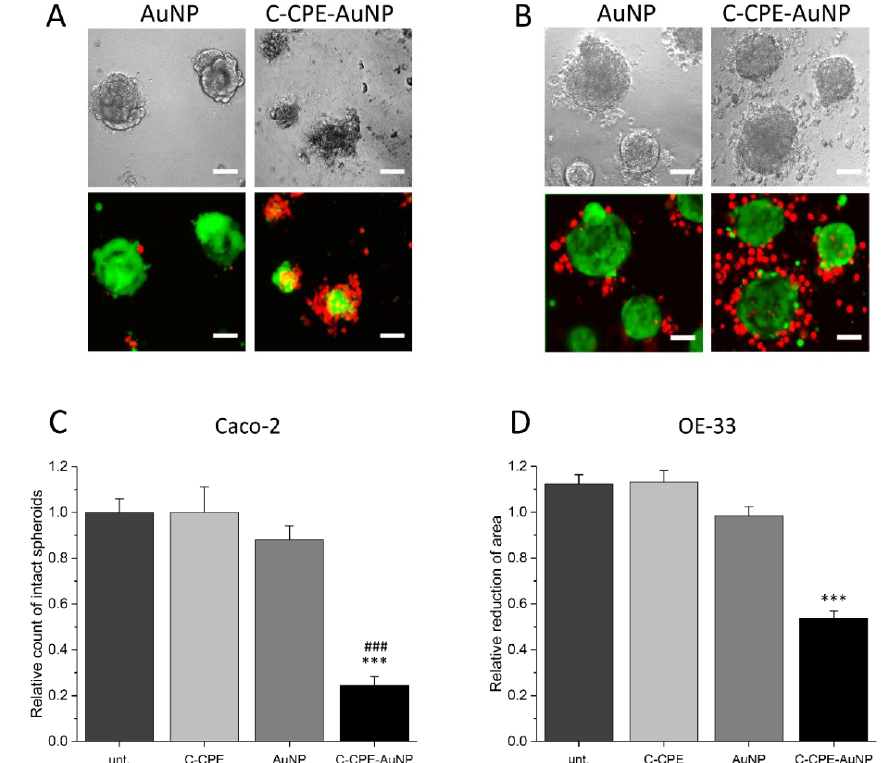
Figure 2. Caco-2 and OE-33 spheroids after three-time application of GNOME-LP. ( A , B ) Confocal images of Caco-2 (A) and OE-33 (B) spheroids treated with GNOME-LP in the presence of AuNPs or C-CPE-AuNPs. C-CPE-AuNPs destroyed Caco-2 spheroid structure and reduced cell survival as shown by the large amount of propidium iodide (red)-positive cells and the reduced amount of calcein-positive cells. For OE-33 spheroids, treatment with GNOME-LP in the presence of C-CPE-AuNPs induced cell death (propidium iodide-positive cells) in the peripheral regions. The cells in the core were still calcein-positive and propidium iodide-negative, indicating that they were still alive. Scale bar, 50 µm. ( C ) Quantification of intact Caco-2 spheroids indicating reduced intact spheroids after GNOME-LP with C-CPE-AuNPs. Graphs represent the mean ± SEM of intact spheroids count relative to spheroids before GNOME-LP application. The results were analyzed with Student’s t test. * Significant difference to untreated spheroids: *** p < 0.001 and ### p < 0.001 significant difference to the AuNPs treated spheroids. ( D ) Quantitative evaluation of OE-33 spheroid area showing that GNOME-LP applied in the presence of C-CPE-AuNPs reduced the spheroid area compared to the spheroid treated in absence of C-CPE-AuNPs. Graphs represent the mean ± SEM of the spheroid area reduction relative to spheroid area before laser irradiation. The results were analyzed with Student’s t test. * Significant di ff erence to the spheroid area before laser irradiation: *** p <